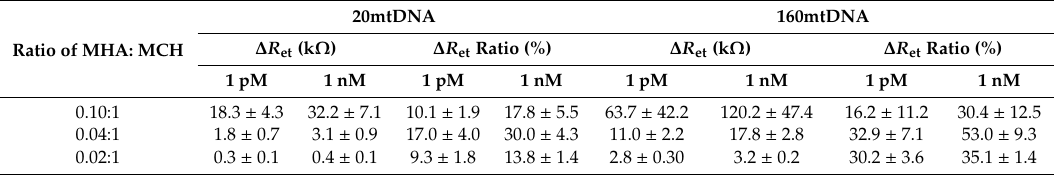
Table 2. Comparison of the R et Increment ( ∆ R et = R et-tDNA − R et-pDNA ) and the ∆ R et ratio (%) ( = ( ∆ R et / R et-pDNA ) × 100)MeasuredfromDifferentpDNA / MHA / MCH / AuGenosensorsafterHybridization with 20mtDNA and 160mtDNA. Each Value is Calculated from Three Individual